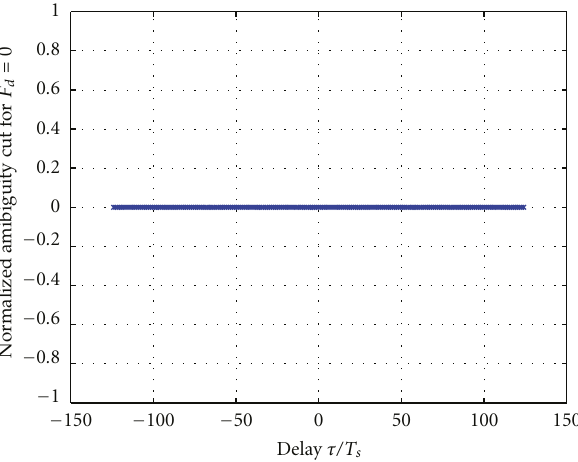
Figure 2: Periodic cross-correlation property of optimized punc- tured